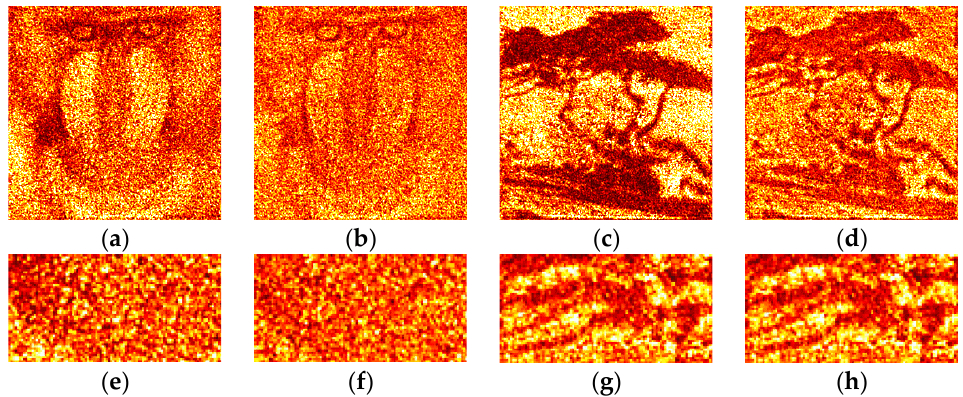
Figure 12. Examples of optically reconstructed images. The holograms were binarized using the Otsu ( a , e and c , g ) and Sauvola ( b , f and d , h ) methods.